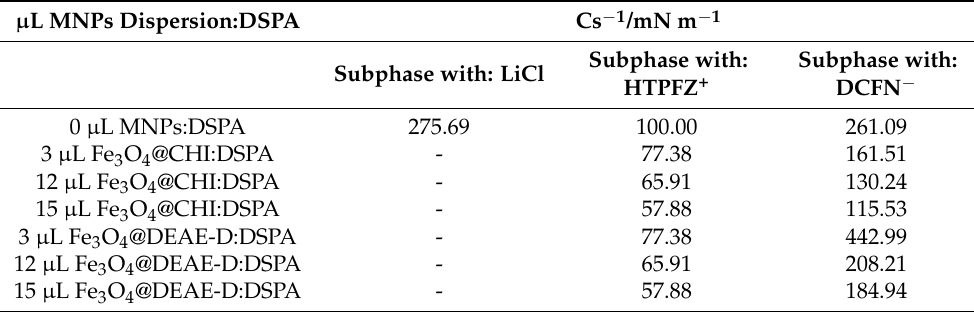
Table 1. Compression modulus at π = 30 mN m − 1 for DSPA and MNPs:DSPA monolayers. Subphase composition: 10.0 mM LiCl for pure DSPA and 0.01 mM HTPFZ + or DCFN − and 10.0 mM LiCl.